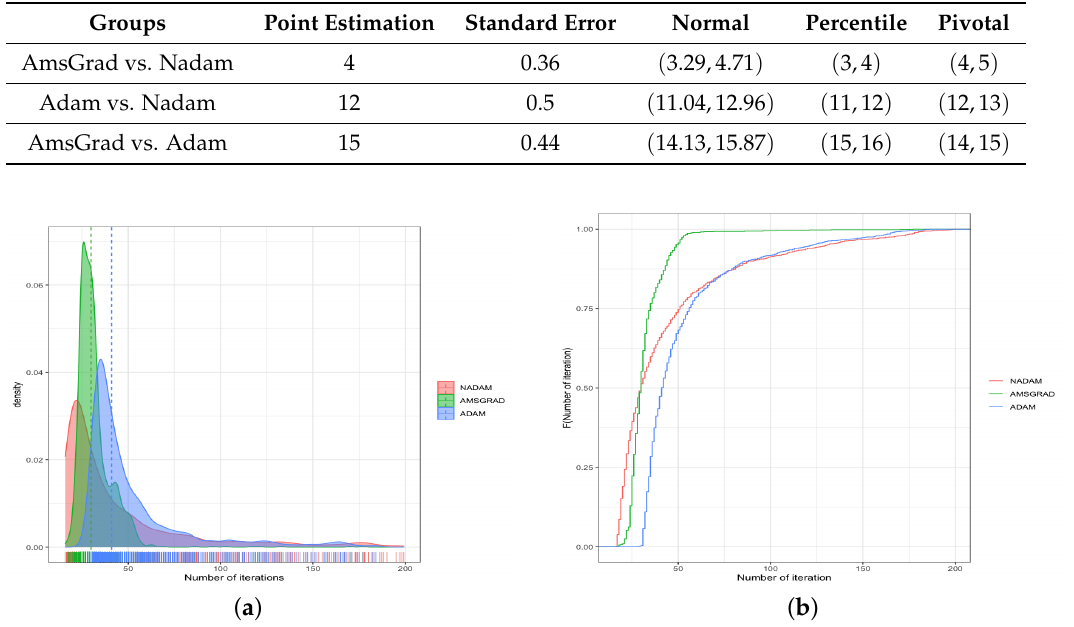
Figure 3. ( a ) Densities of number of iteration for each optimizer and ( b ) the empirical cumulative density